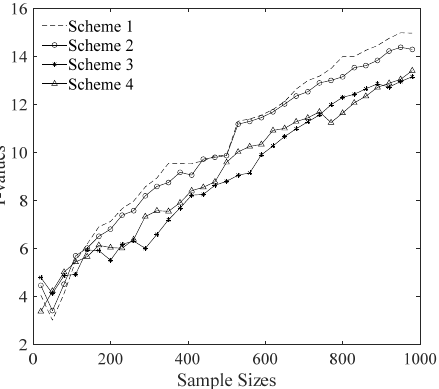
Figure 5. The maximum t -values of each scheme under different total sample sizes on the MCU platform. MCU